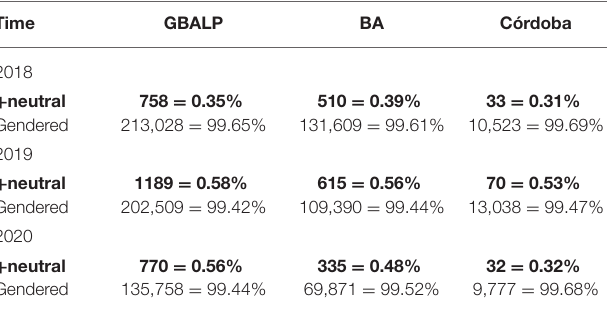
TABLE 4 | Frequency of ± neutral gender expressions per